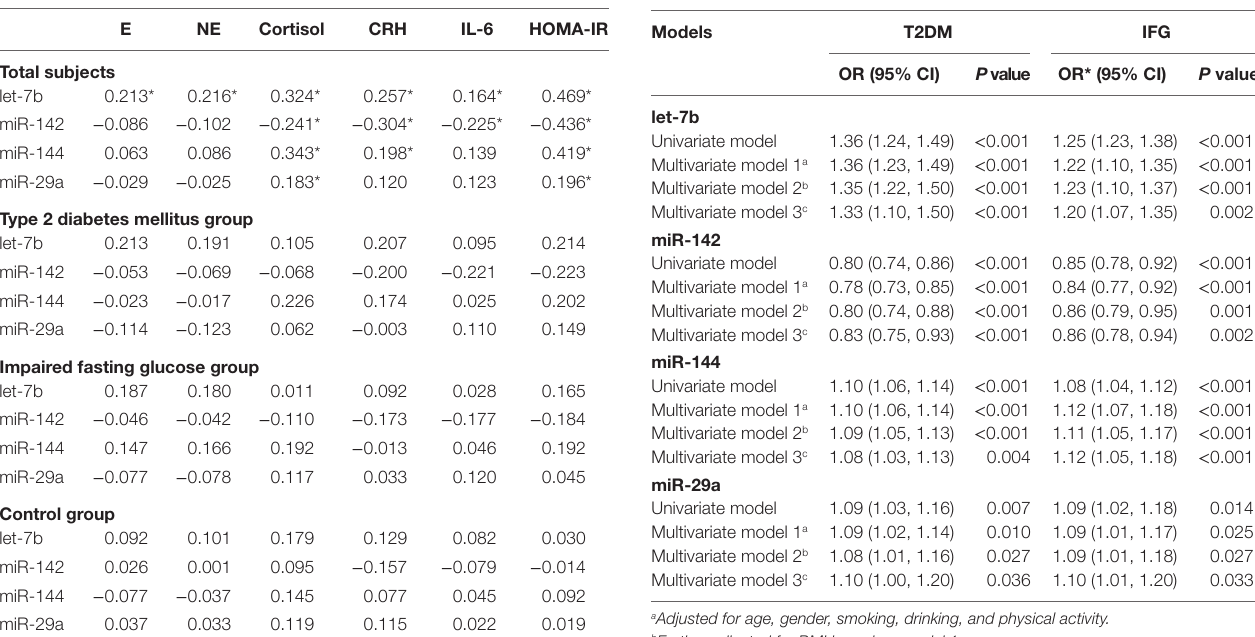
TaBle 5 | Spearman correlation among the microRNAs and stress hormones and